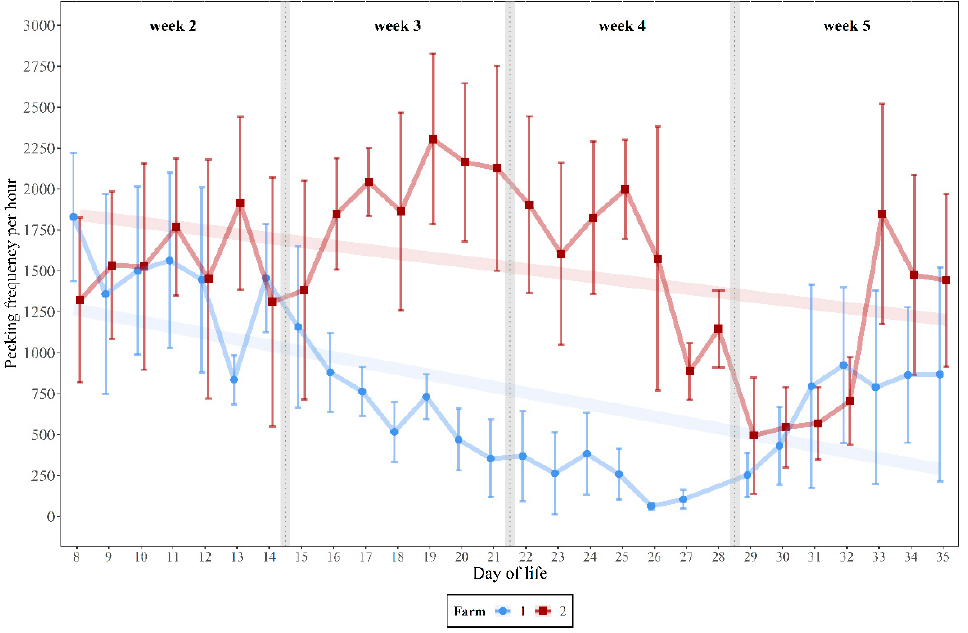
Figure 1. Mean values and standard deviations of pecking frequencies per hour for life day 8–35 on farm 1 and 2 ( n = 12 h) and Spearman correlations (watermarks) with day of life ( n = 28 days; farm 1: missing value on day 28).